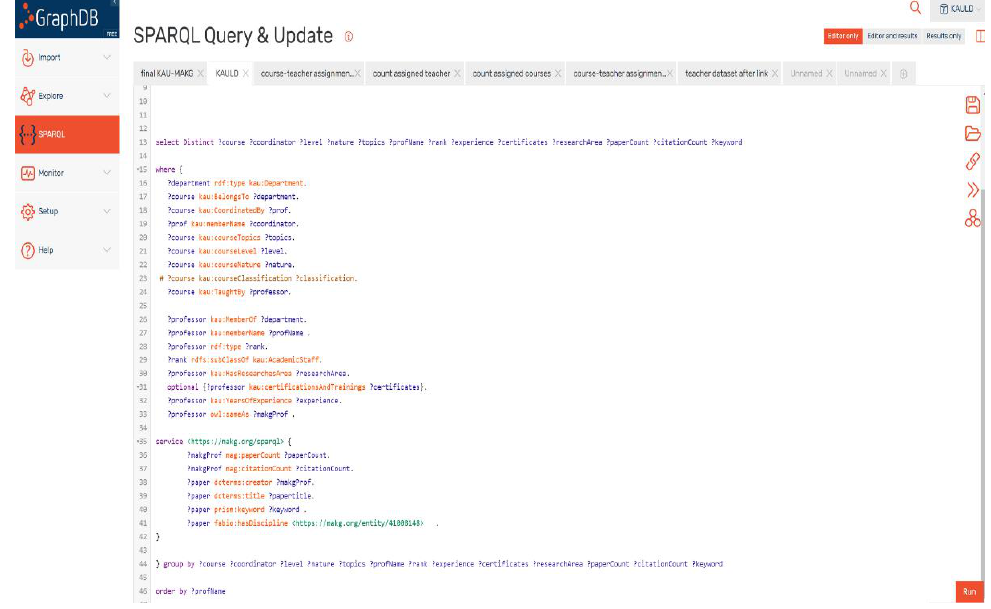
Figure 12. Example of extracting data from KAULD using federated query.